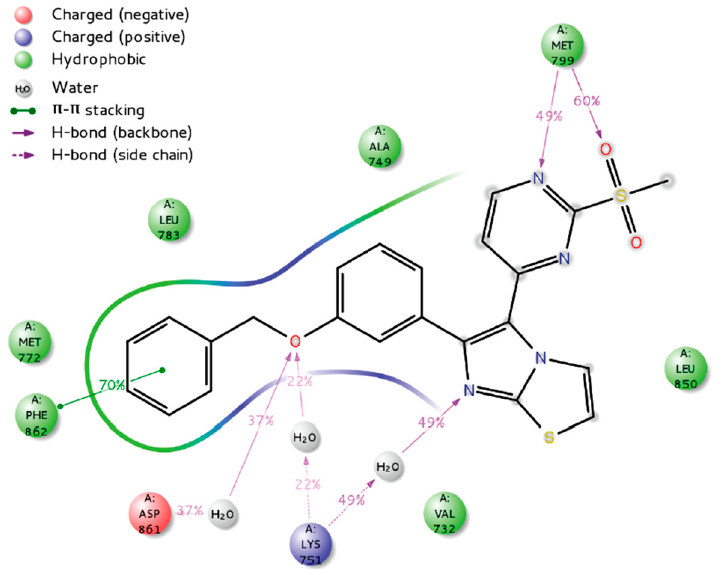
Figure 6. Putative binding interactions of compound I with HER4 active site [161]. Reprinted with permission from ref. [161]. Copyright 2021 Elsevier. Table 1 summarizes the structures, potency, biological activities, and clinical trials (in case of clinical candidate) of the reported HER4 inhibitors. Table 1. Structures, potency, biological activities, and clinical trials (if any) of the reported HER4 inhibitors.